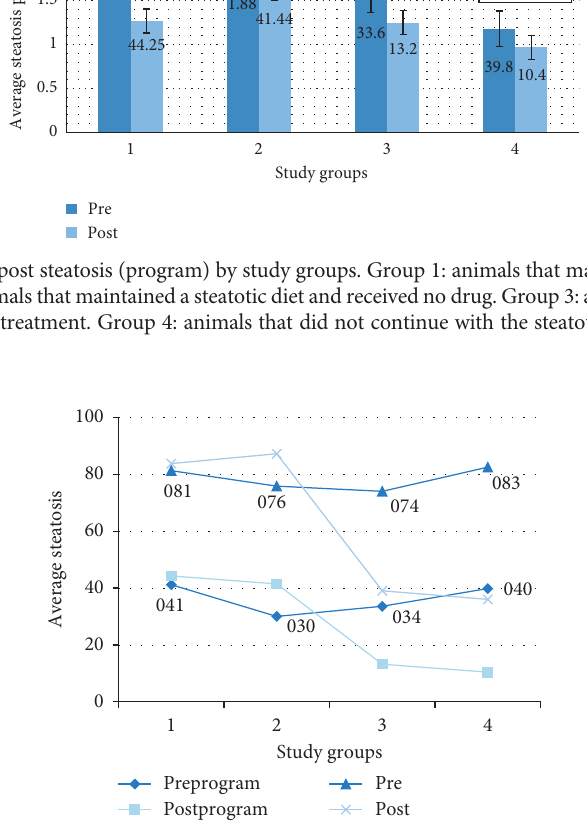
Figure 10: Percentage of average pre-post steatosis (program) by study groups. Group 1: animals that maintained a steatotic diet and received concomitant treatment. Group 2: animals that maintained a steatotic diet and received no drug. Group 3: animals that did not continue with the steatotic diet but received melatonin treatment. Group 4: animals that did not continue with the steatotic diet and did not receive any